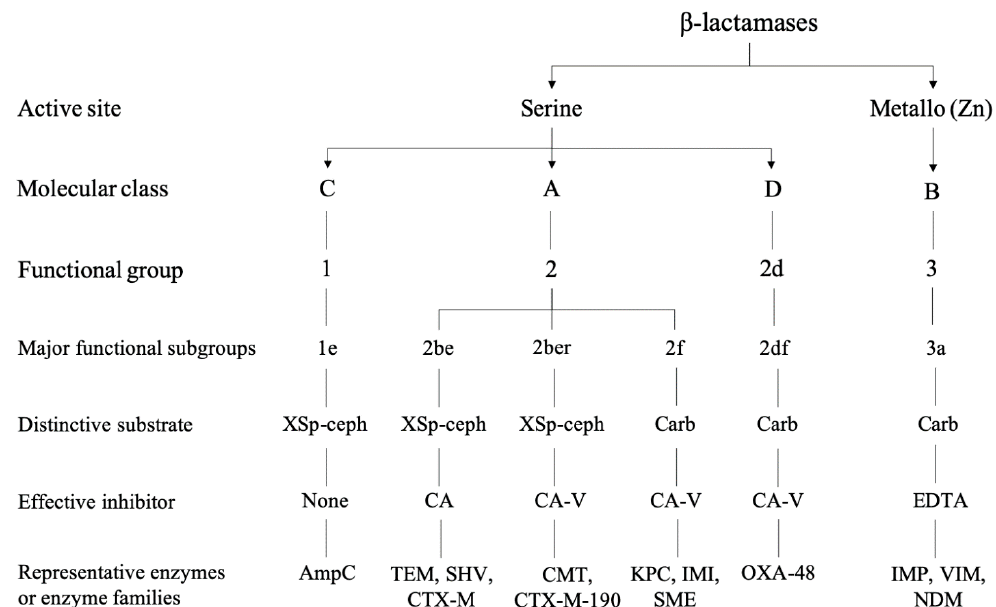
Figure 2. Molecular and functional relationships among β -lactamases conferring resistance to selected cephalosporins or carbapenems (adapted from reference 10 with permission). XSp-ceph, expanded-spectrum cephalosporins; Carb, carbapenems; CA, clavulanic acid; CA-V, variable response to clavulanic acid; EDTA, ethylene diamine tetra-acetic acid.